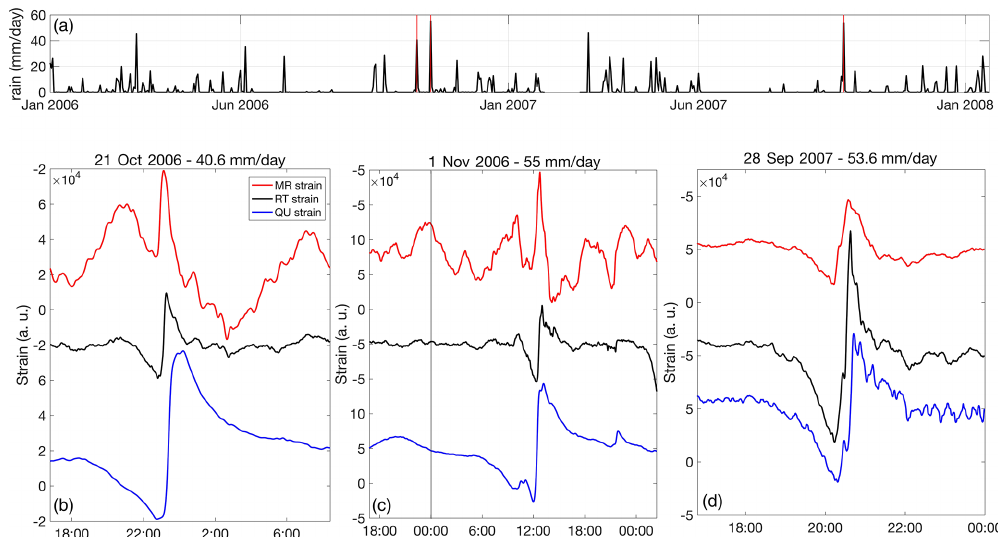
Figure 6. Exogenous events, caused by three different rainfall episodes. In (a) it is depicted the rain in mm/day from 1 January 2006, up to 28 January 2008 recorded by the Agnano rain sensor (data from CAR – Regione Campania). (b) , (c) , and (d) represent RT, MR and QU strainmeters data for the three most significant rainfall events, the first of them is accompanied by the VT swarm. Strainmeter data for other intense rainfalls are missing. Strain data are plotted relative to an arbitrary datum, and in (b) and (c) QU data have been multiplied by a factor 2.